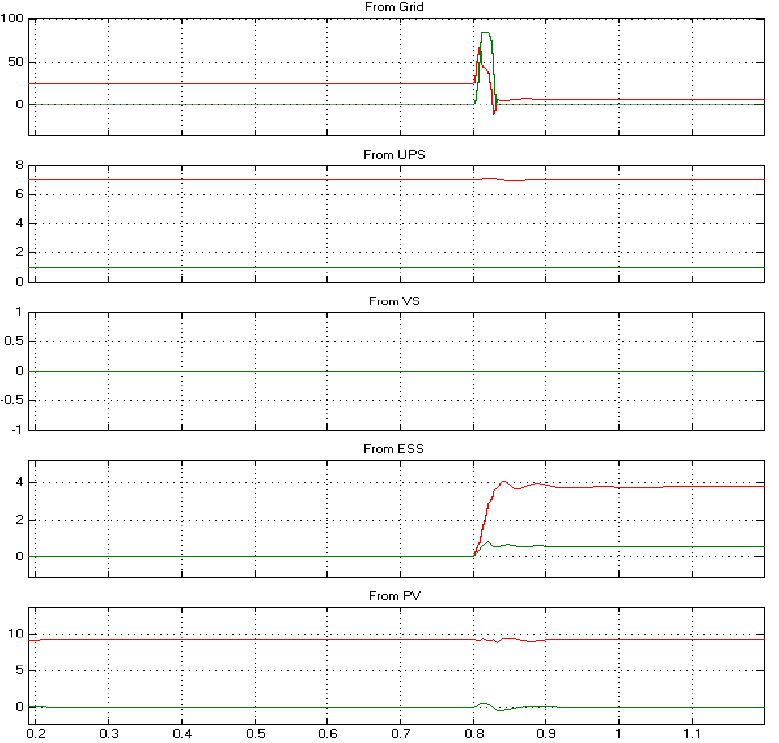
Figure 18. Simulation results for load sharing by DES in on grid mode during tariff change from low to high.